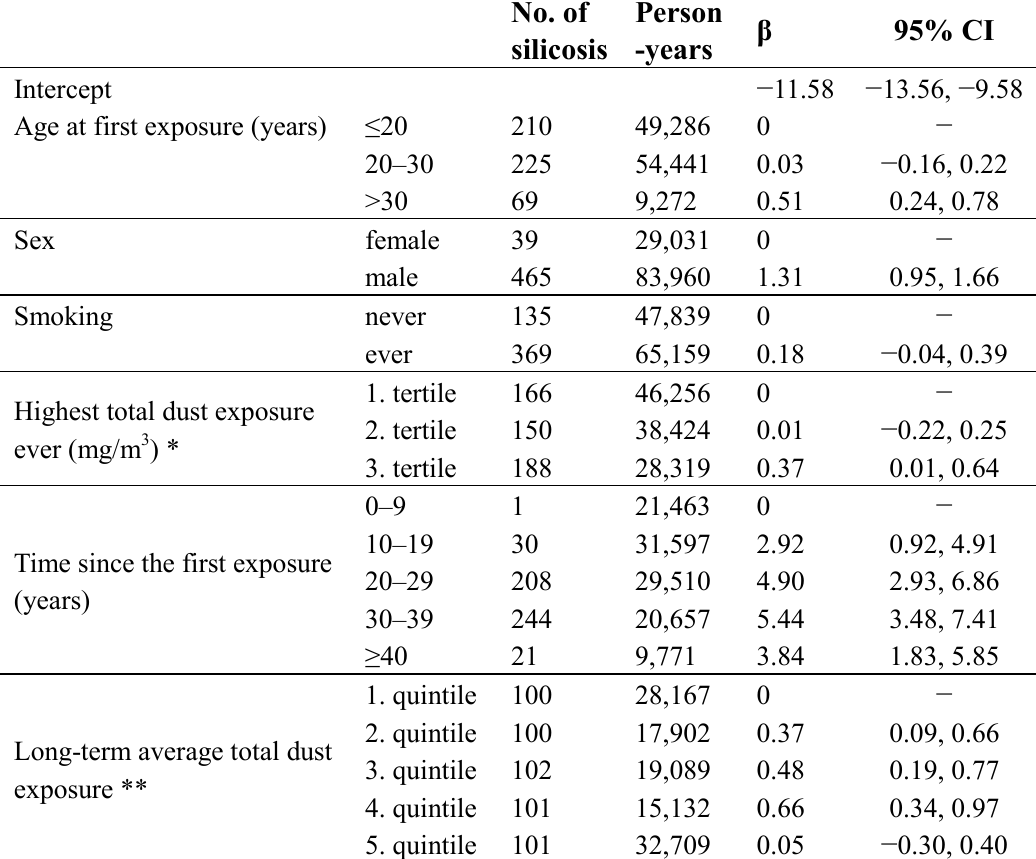
Table 3. Results of Poisson-regression analysis based on total dust exposure.